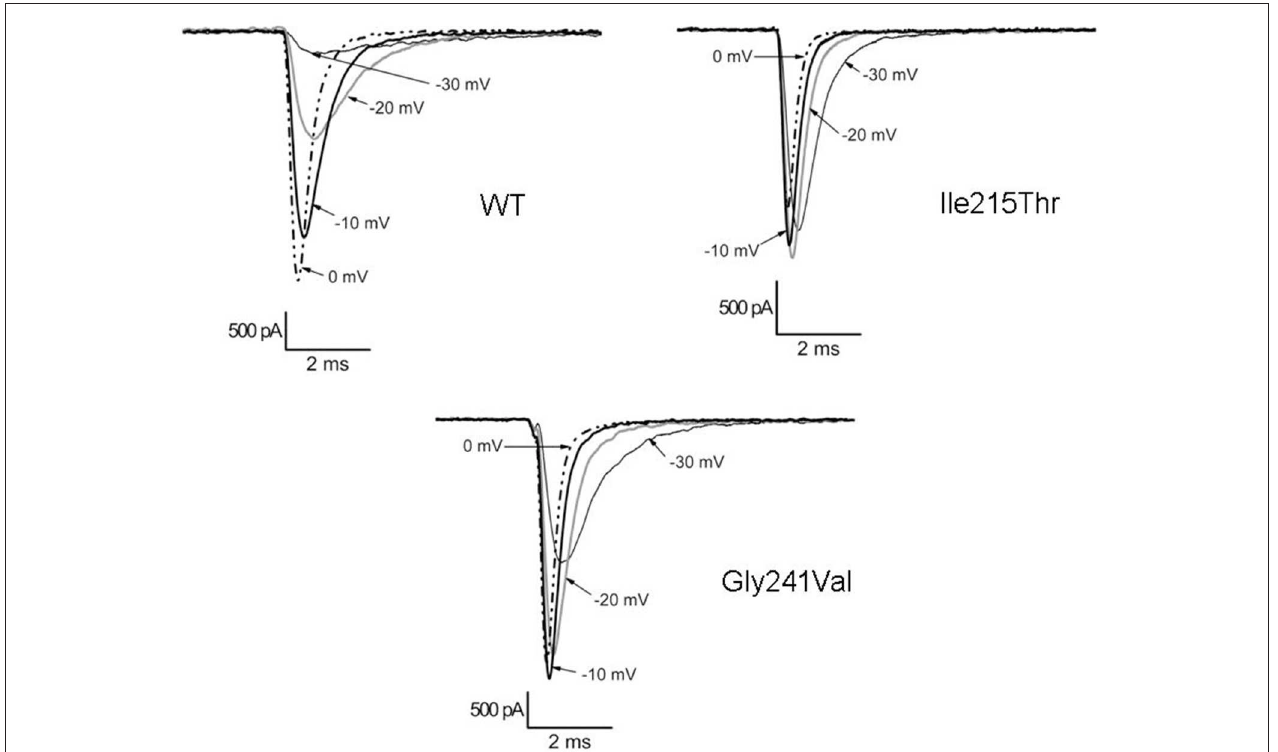
FIGURE 3 | Traces illustrating the current decay for WT and mutant channels.